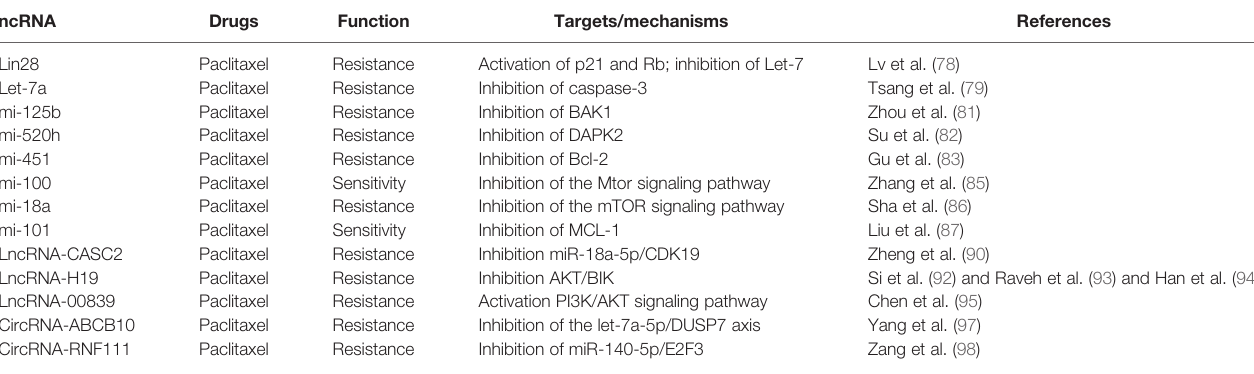
TABLE 3 | Breast cancer paclitaxel chemoresistance-related